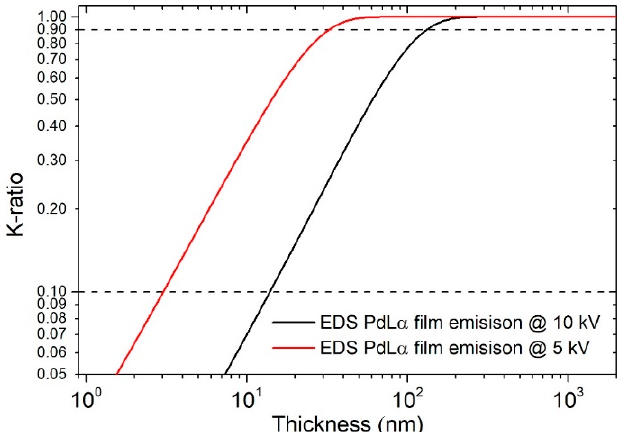
Figure 15. Log–log plot of the emission of Pd film on Cu as a function of the thickness using a 5 and 10 kV electron beam. The 10%–90% thickness range is marked.